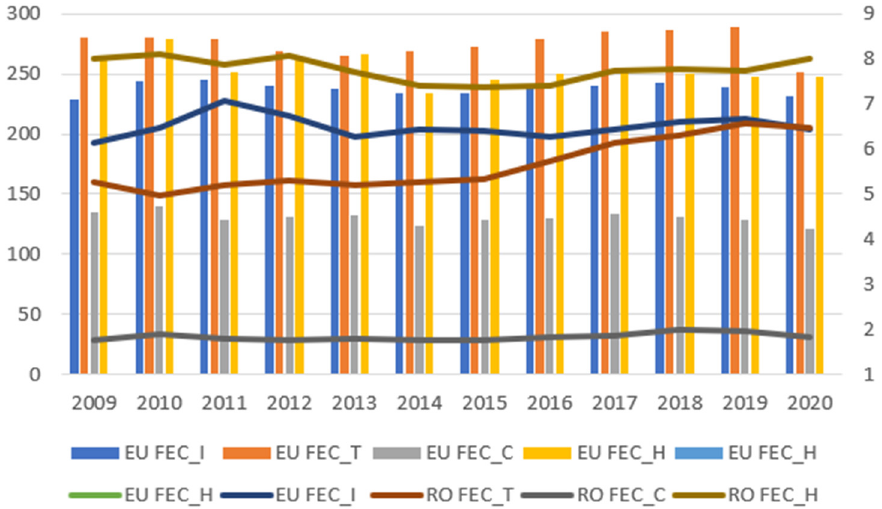
Figure 2. Evolution of final energy consumption by sectors (MTOE) from 2009 to 2020.